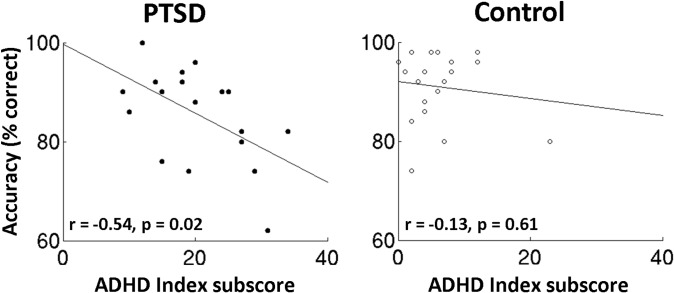
ADHD Index subscores on the Conners test correlates with Extra-dimensional set-shifting task accuracy for the PTSD group (p<0.05), but not for the Control group (p>0.05).